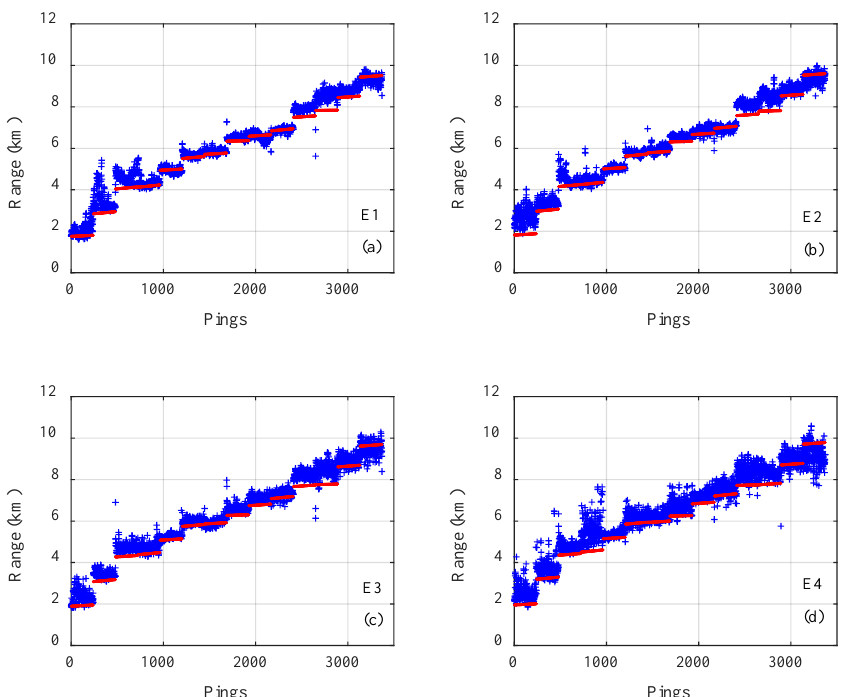
Figure 5. The true range (red) and the estimated range of the classification convolutional neural network (blue) for all 3371 samples on track 1 with emission energy of ( a ) E1, ( b ) E2, ( c ) E3, ( d ) E4.